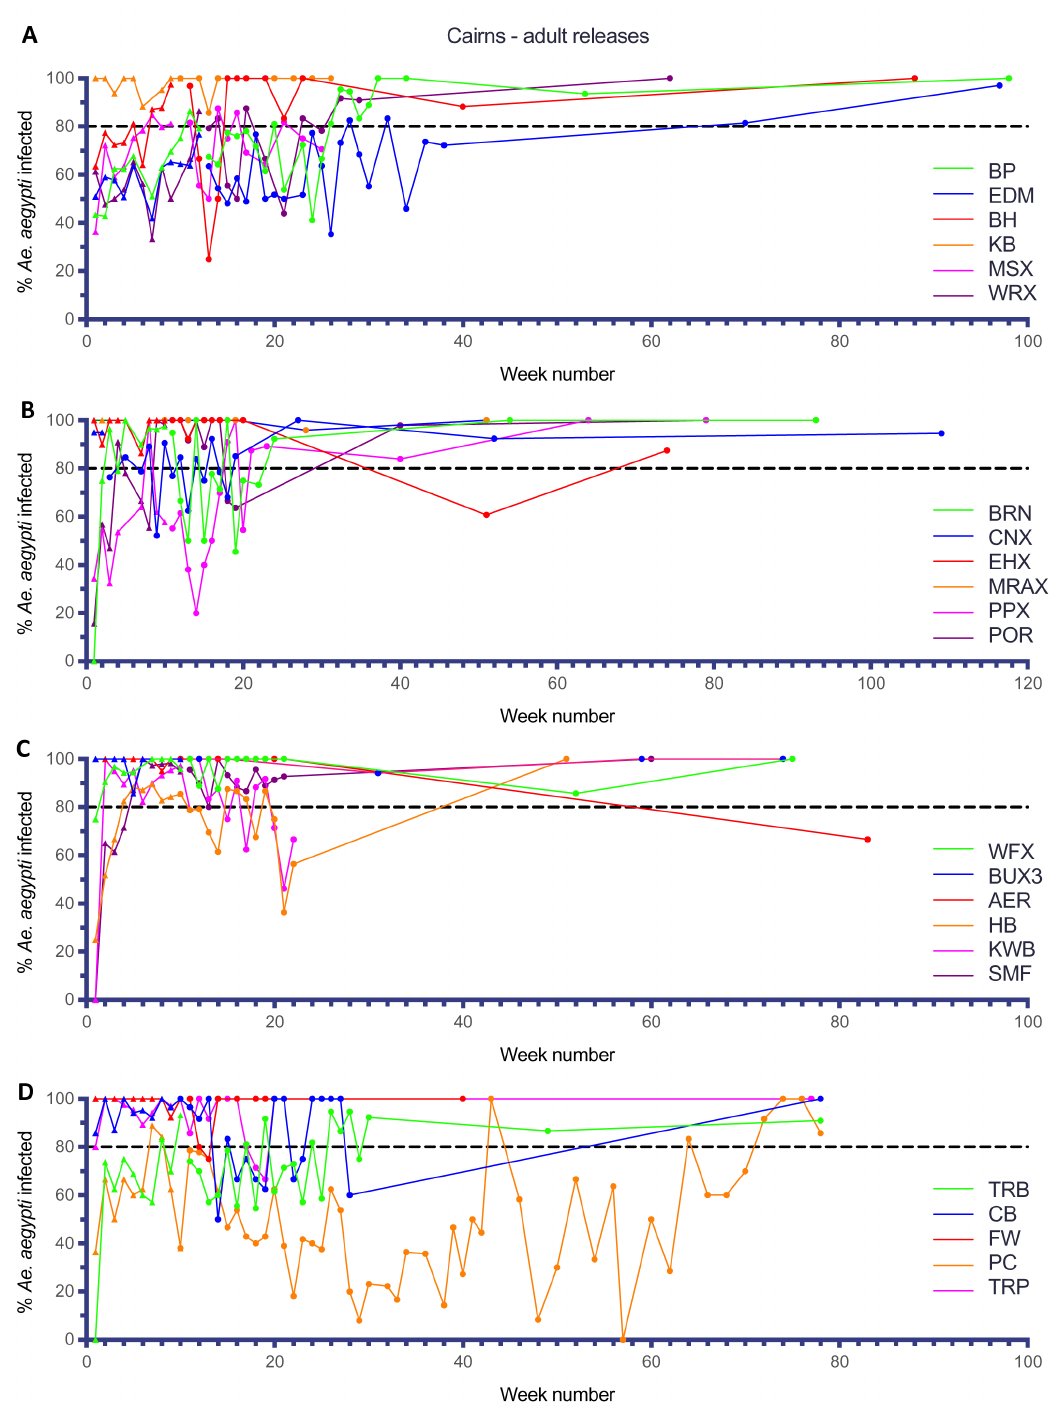
Figure 10. Wolbachia infection rates in Aedes aegypti mosquitoes collected from Bentley Park (BP), Edmonton (EDM), Bayview Heights (BH), Kanimbla (KB), Mount Sheridan Ext (MSX) and White Rock Ext (WRX) ( A ), Brinsmead (BRN), Cairns North Ext (CNX), Edge Hill Ext (EHX), Manoora Ext (MRAX), Parramatta Park Ext (PPX) and Portsmith (POR) ( B ), Whitfield Ext (WFX), Bungalow Ext 3 (BUX3), Aeroglen (AER), Holloways Beach (HB), Kewerra Beach (KWB) and Smithfield (SMF) ( C ), Trinity Beach (TRB), Clifton Beach (CB), Freshwater (FW), Palm Cove (PC) and Trinity Park (TRP) ( D ) during release (triangles) and post-release (circles) monitoring periods ( Wolbachia infected adult releases were undertaken every week for 9–11 weeks in BP, EDM, BH, KB, MSX and WRX between Nov 2016 and May 2017, for 3–9 weeks in BRN, CNX, EHX, MRAX, PPX and POR between Mar–May 2017, for 5–10 weeks in WFX, BUX3, AER, HB, KWB and SMF between Mar–Jul 2017, for 9–10 weeks in TRB, CB, FW, PC and TRP between May–Aug 2017), Week number 1 corresponds to commencement of Wolbachia mosquito releases in each